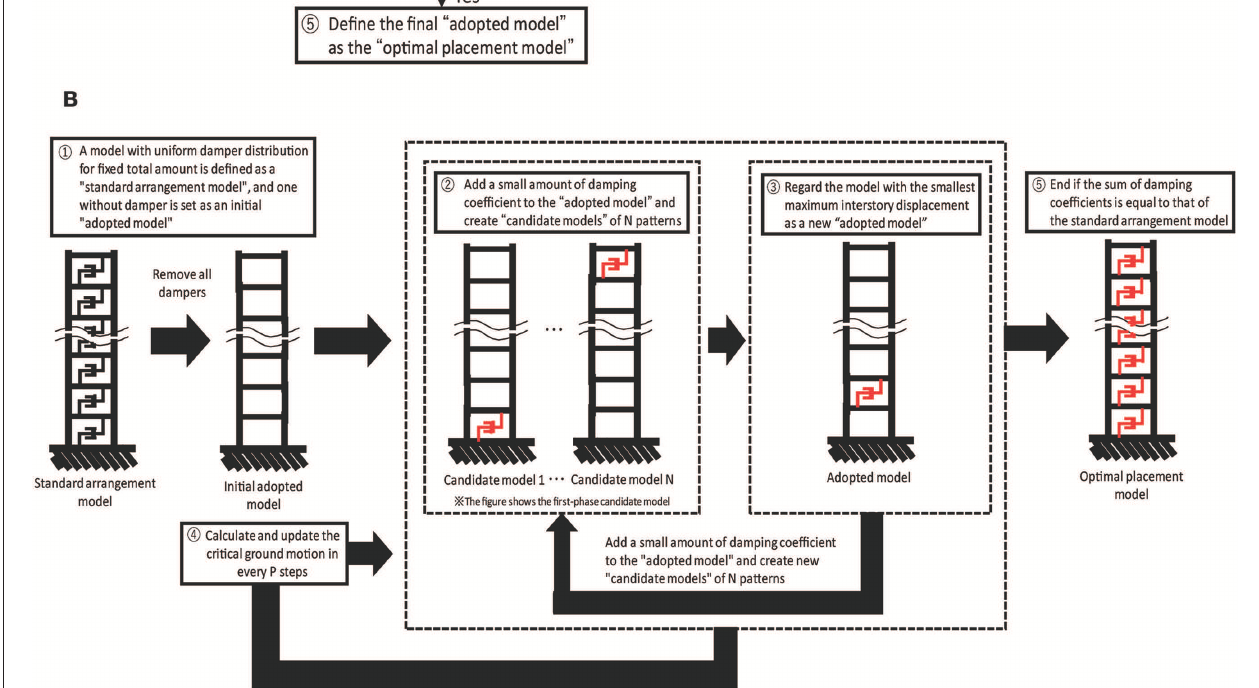
Frontiers in Built Environment |